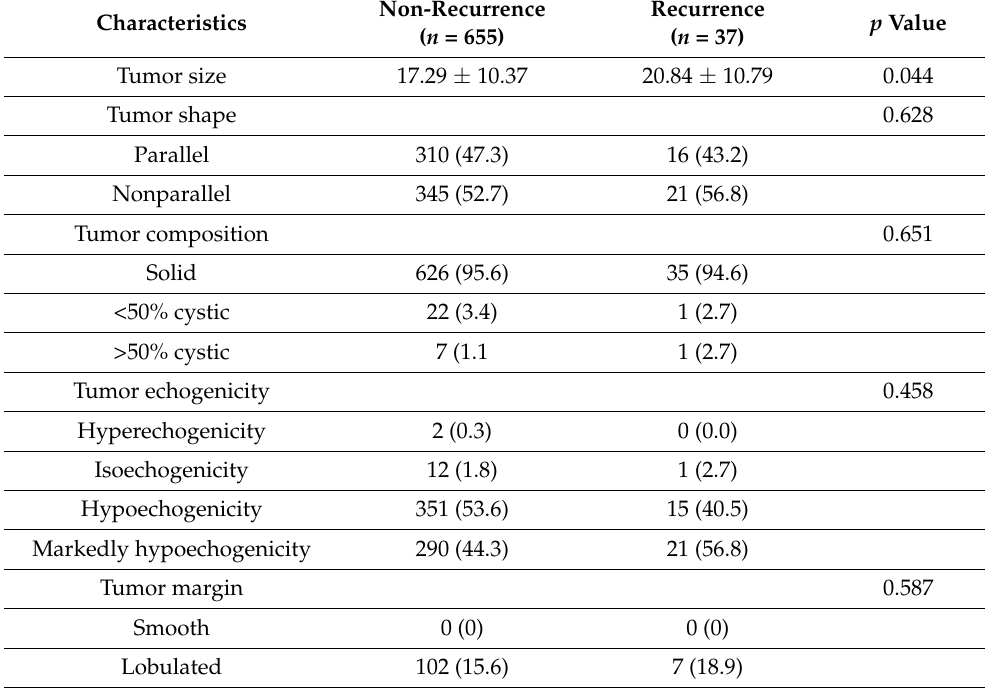
Table 2. Ultrasound features of the index tumor and lateral lymph nodes in patients with N1b papillary thyroid carcinoma according to